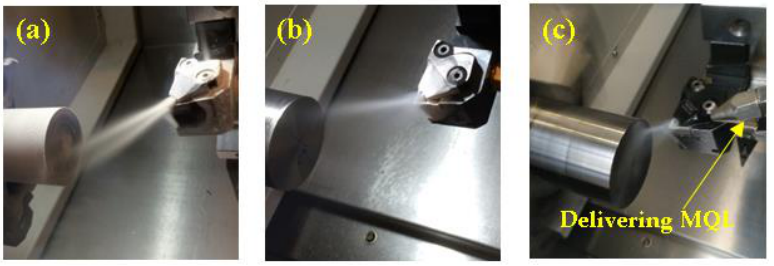
Figure 1. Experimental setup ( a ) delivering LN 2 ; ( b ) CO 2 from the rake and flank faces; ( c ) CO 2 from the rake and flank faces and MQL from the rake face.